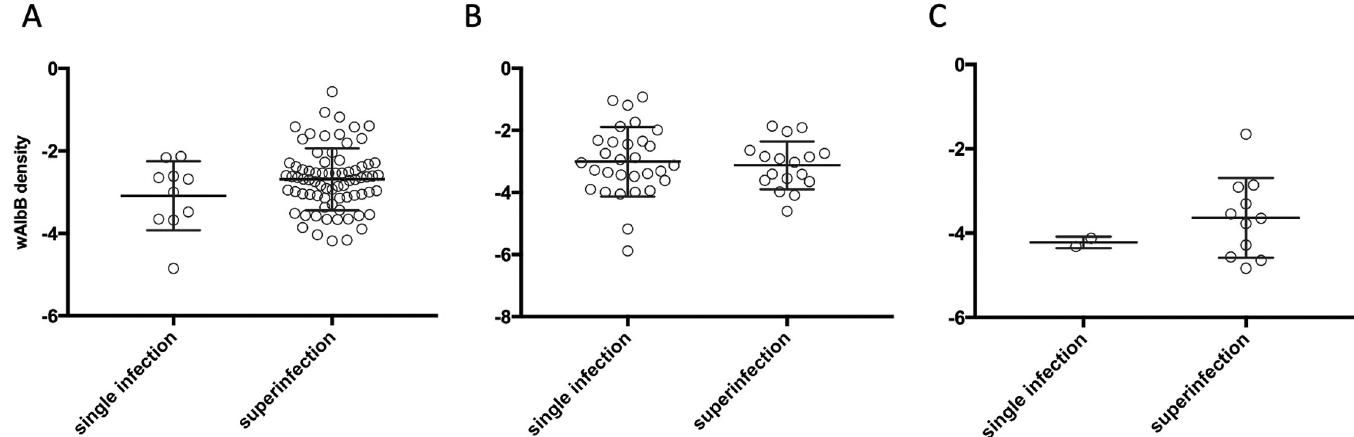
Fig 5. Female (A) and male (B) w AlbB density in single-infected and superinfected Ae . albopictus from Torres Strait and female (C) w AlbB density in single- and superinfected Ae . albopictus from Vietnam. Vertical lines and error bars represent medians and 95% confidence intervals.